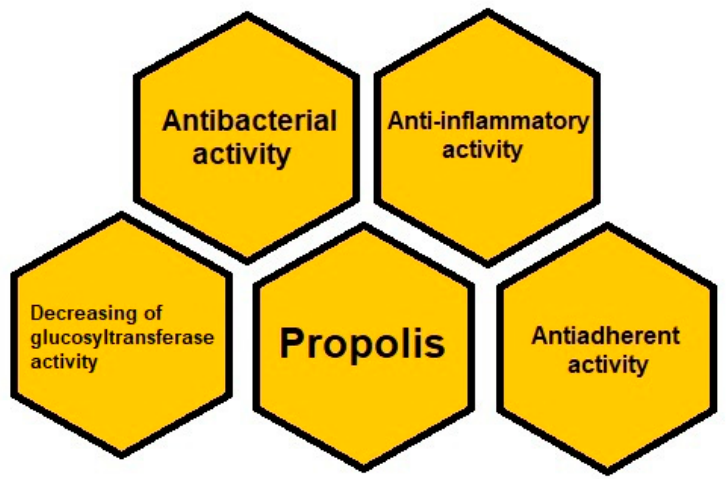
Figure 3. Anti-plaque action of